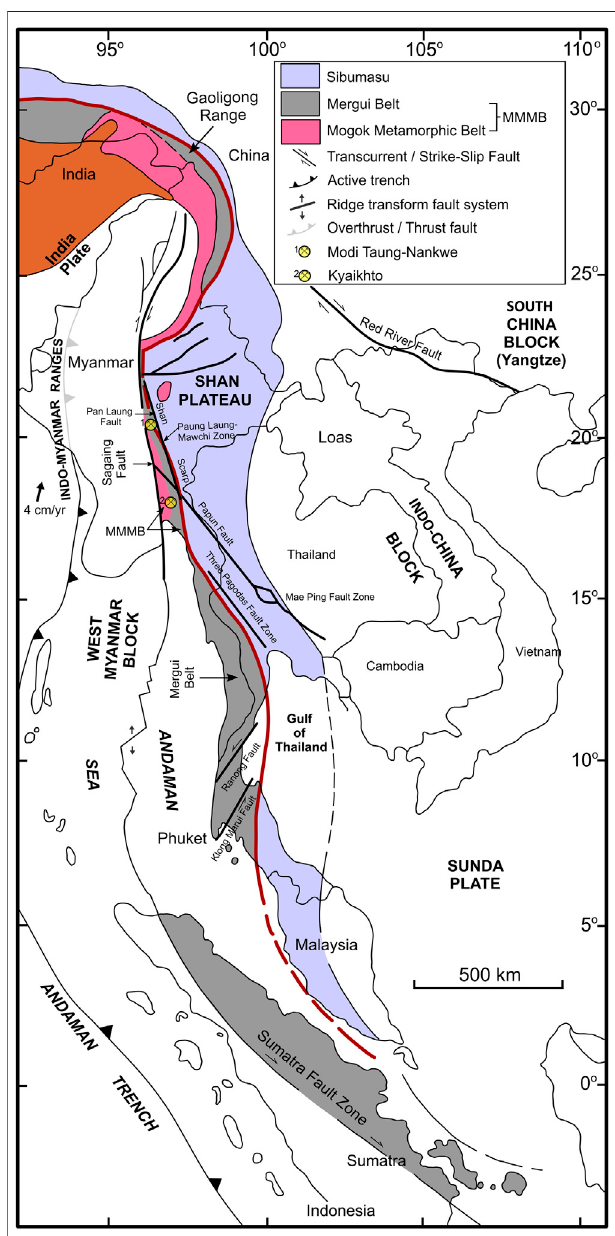
FIGURE 2 | Regional tectonic setting of Myanmar and distribution of Mergui Belt (Gaoligong Range and its southeastward continuation through ThailandintoIndonesia).RedlineateasternmarginofMerguiBeltistheMedial Myanmar suture zone (Modi fi ed after Mitchell, 2018). MMMB, Mogok- Mandalay-Mergui